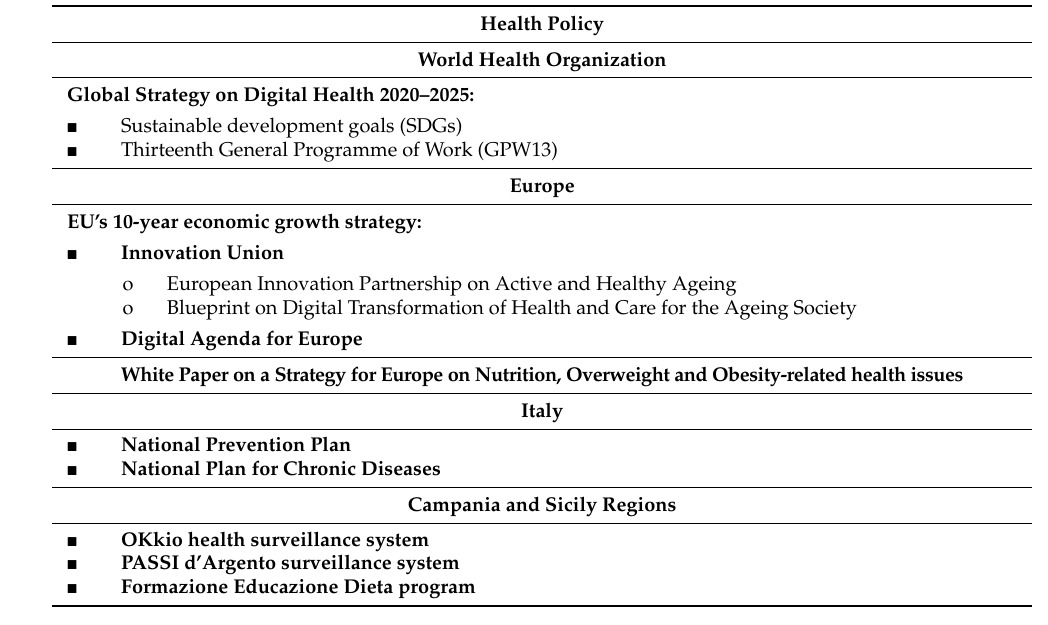
Table 1. Overview of health